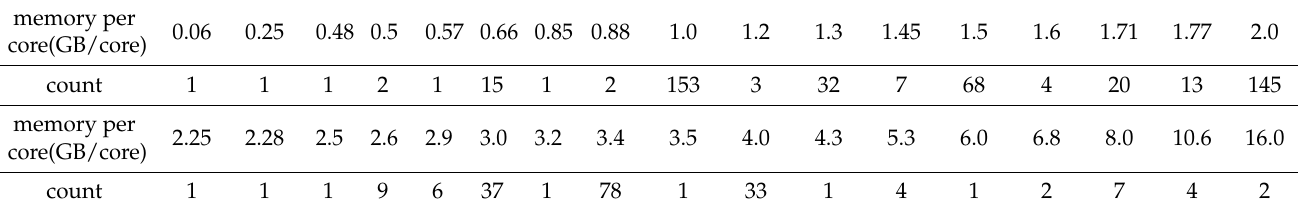
Table 1. Memory pre core statistics of published servers with SPECpower_ssj